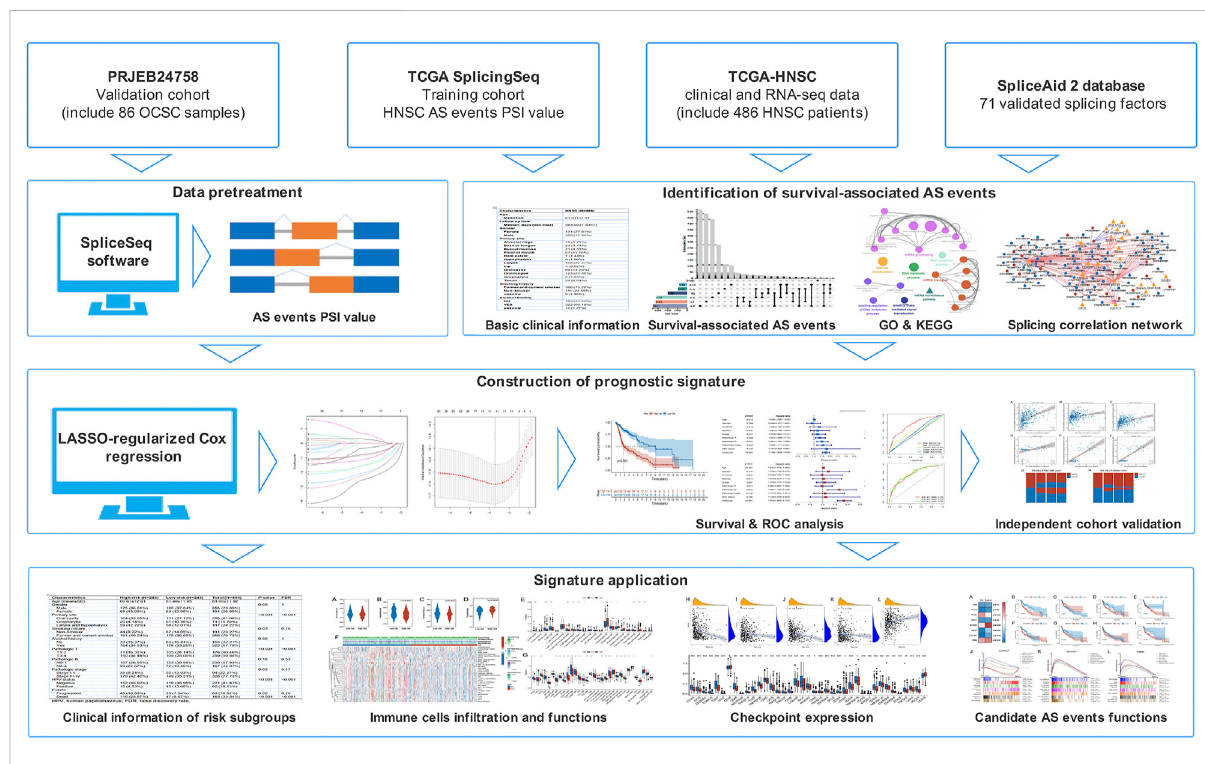
FIGURE 1 The fl ow chart of AS-based prognostic signature construction and